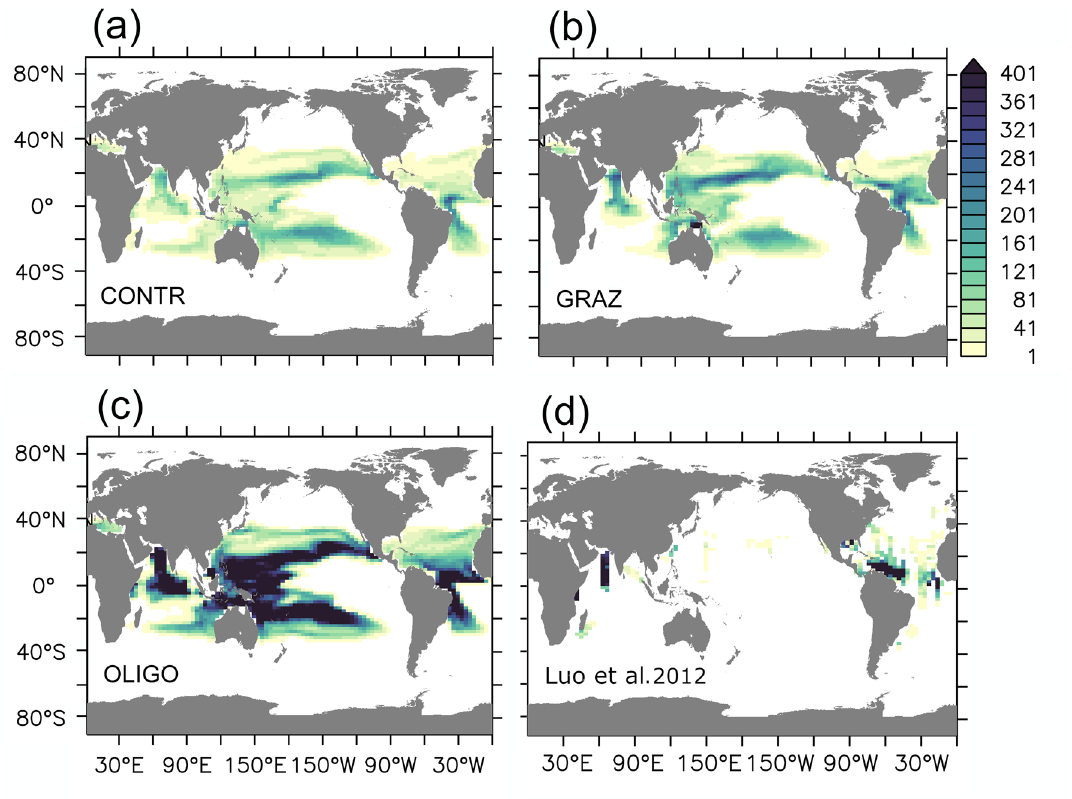
Figure 2. Annual mean diazotrophic biomass inventories in the upper 100 m in units mg C/m 2 : ( a – c ) refer to simulations CONTR, OLIGO and GRAZ, respectively. ( d ) is based on observations 67 , interpolated linearly over depth and then gridded onto the model